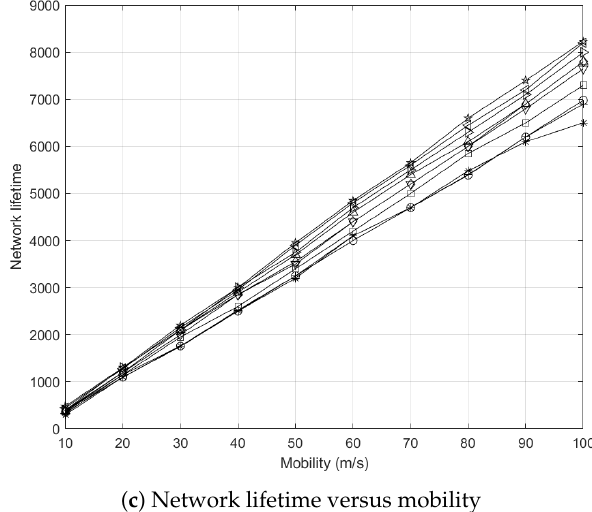
Figure 5. Graphical results for the effects of mobility on RL. Learning rate α = 1.0 achieves the lowest energy consumption and rate of link breakages, as well as the highest network lifetime.